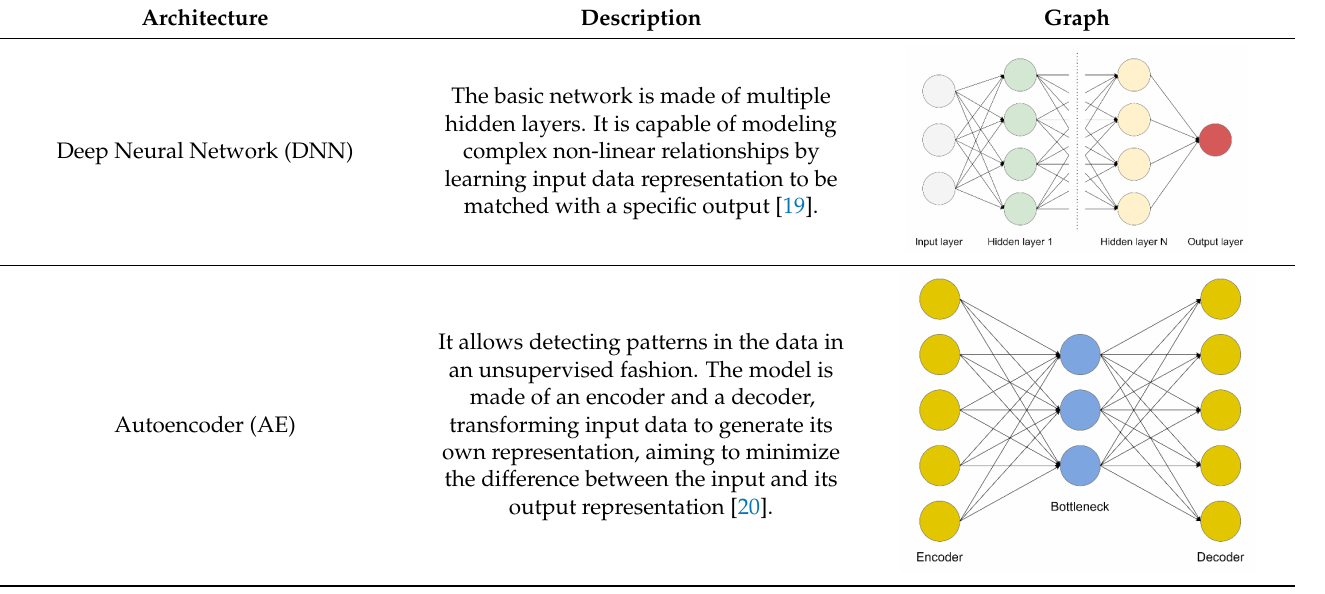
Figure 1. Common algorithm types for ML and DL employed in ND biomedical research. Table 1. Summary of influential DL architectures and approaches for multi-layer big data